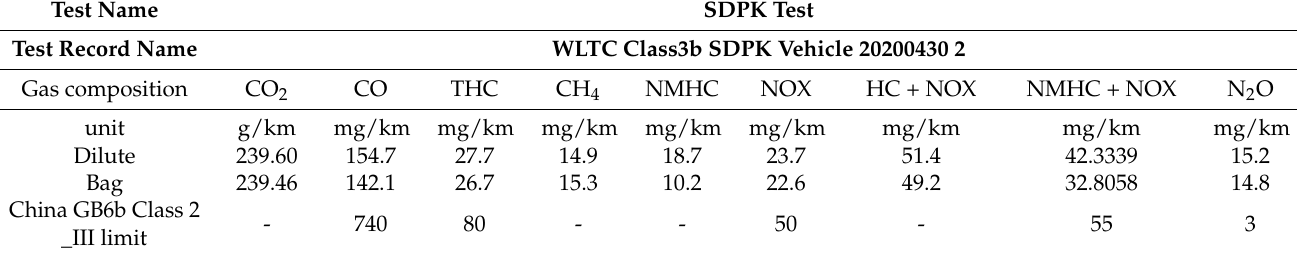
Figure 21. The dynamic output of NOx sensor under driving test.